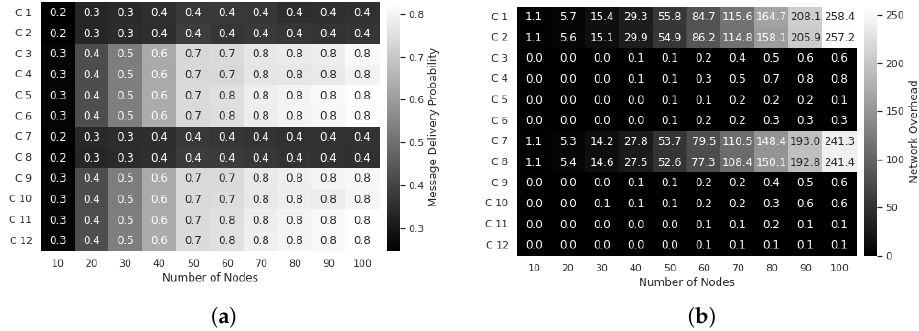
Figure 4. Comparison of Blossom’s settings for the message delivery probability and the network overhead ratio on the map based on Venice. ( a ) message delivery probability; ( b ) network